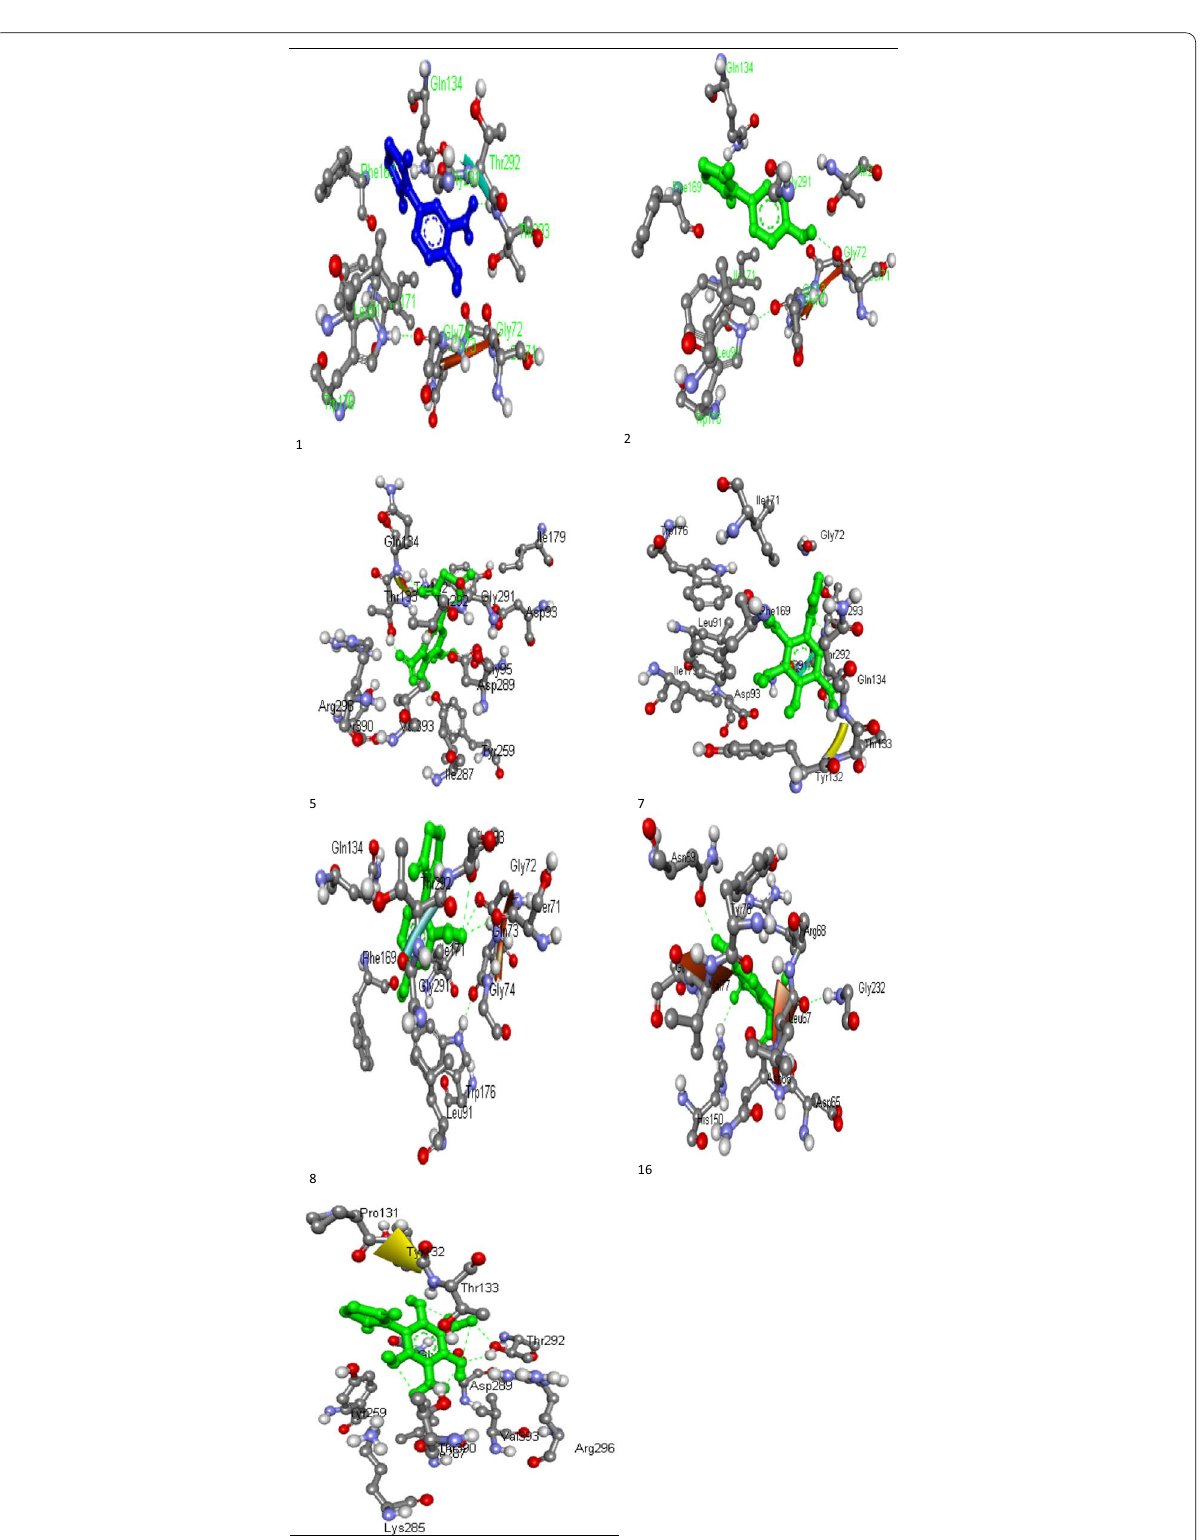
Fig. 7 3D interactions of designed ligands and protein